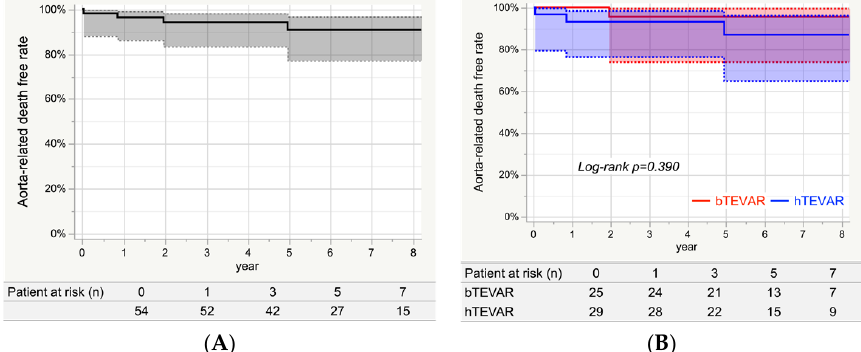
Figure 3. Freedom from aorta-related death. ( A ) Freedom from aorta-related deaths in the entire study group. The event-free rates at 1, 3, 5, and 7 years were 96.3% (95% CI: 86.2 – 99.1%), 94.2% (95% CI: 83.5 – 98.1%), 90.8% (95% CI: 77.2 – 96.7%), and 90.8% (95% CI: 77.2 – 96.7%), respectively. ( B ) Free-